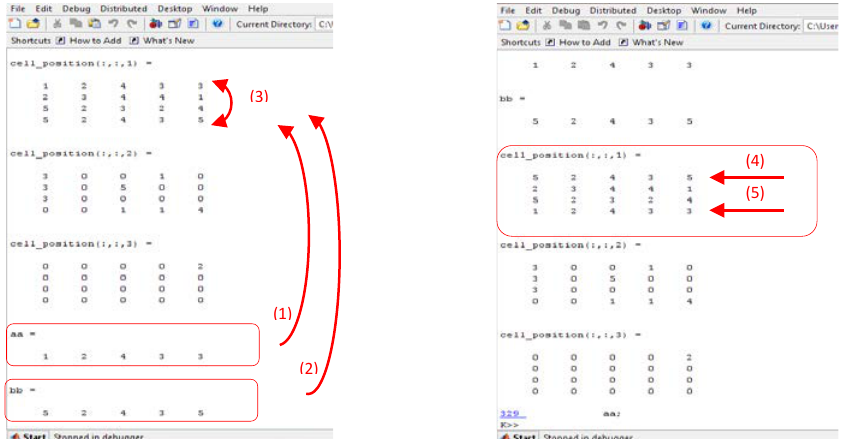
Fig. 8. Choosing two rows for replacement (left image)/ replacing the selected rows in the cell layout (right image)